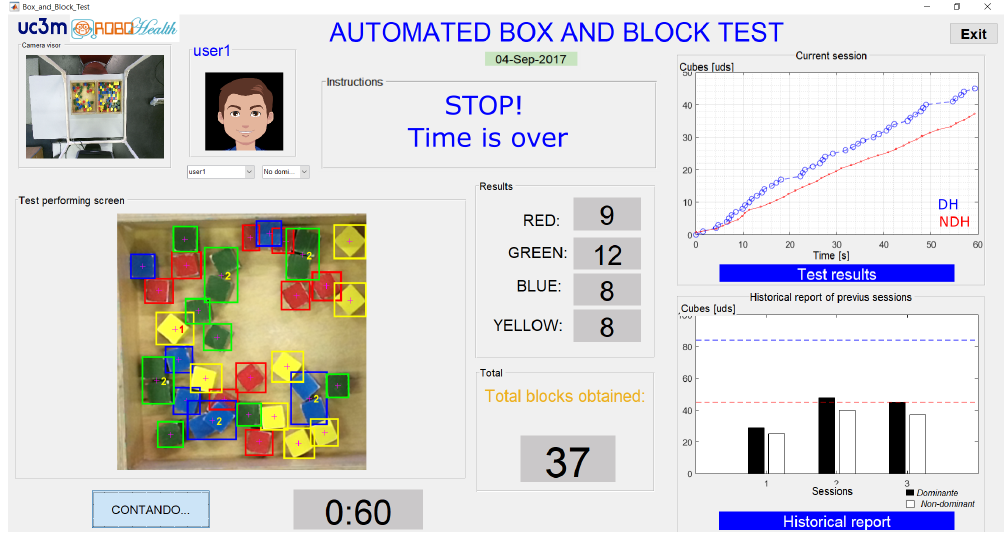
Figure 7. ABBT graphical